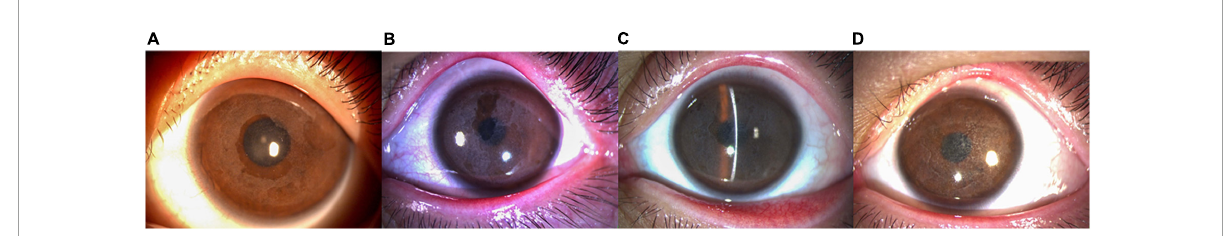
FIGURE2 Anterior segment photography (X16, Topcon, Tokyo, Japan) showed the left eye of patient IV: 1. (A) The patient at 6 years of age (with a disease history of 4 years). The cornea was gray and opaque under the epithelium. However, the cornea in the pupil area still showed a lens presentation. (B) The patient at 12 years of age (with a disease history of 10 years). The corneal subepithelial gray opacity was thicker than in prior examinations and gradually fused into a map shape, blocking part of the pupil. (C) The patient at 15 years of age (with a disease history of 13 years). The entire cornea was seen as a gray and white opacification under the epithelium. (D) The patient was 17 years of age (with a disease history of 15 years). The disease had recurred 2 years after PTK. A white thin layer opacity of the cornea was observed and the range and shape of the opacity were the same as in the initial case presentation.